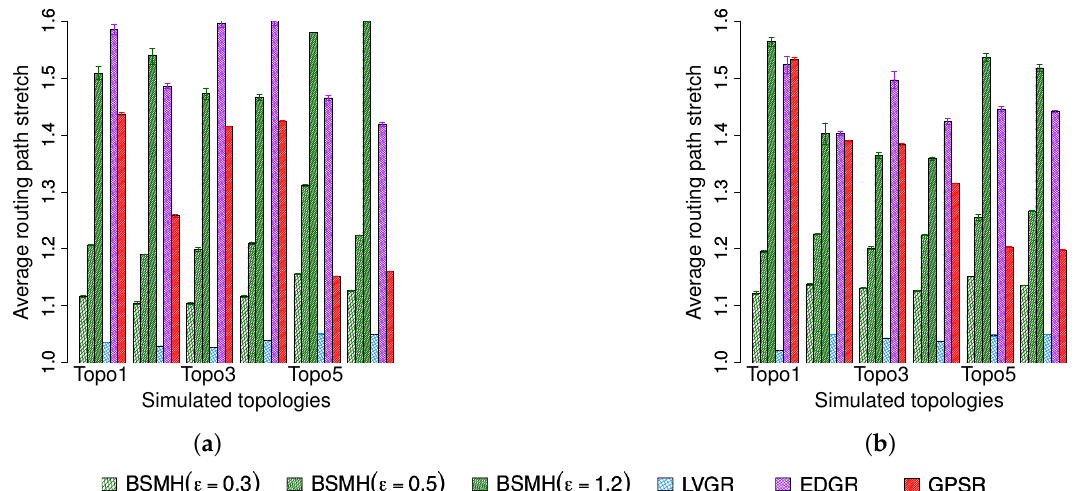
Figure 13. The average routing path stretch of successfully delivered packets [38]. ( a ) 1-n communication. ( b ) n-n